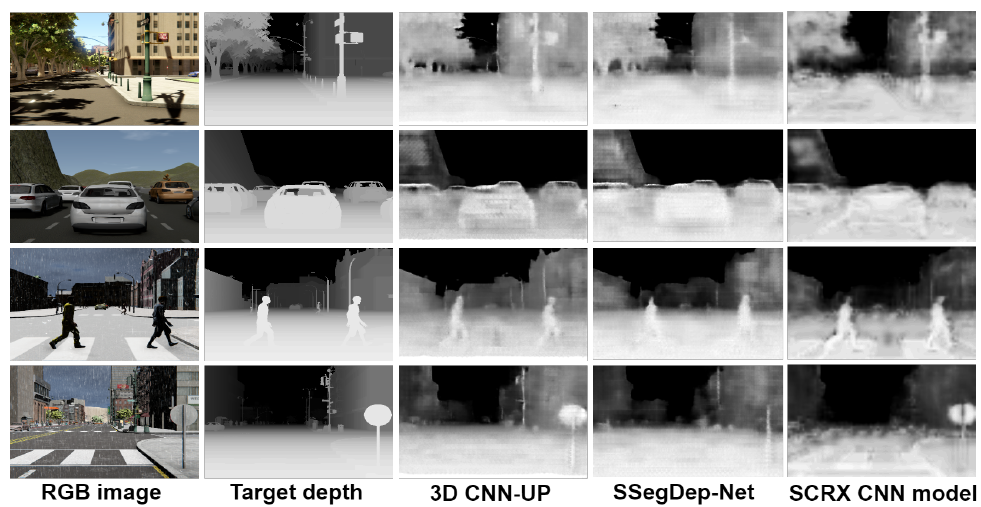
Figure 19. Comparison between the best results of all the CNN models (visually enhanced).